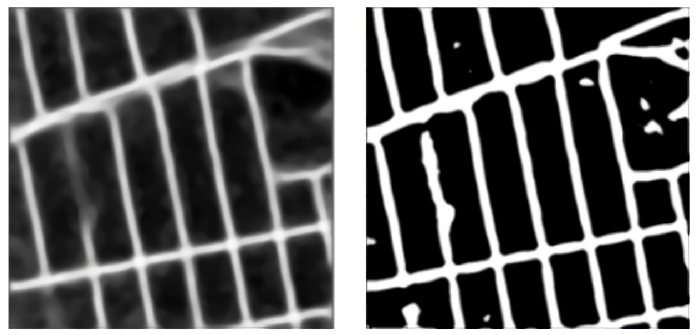
Figure 8. Gaussian adaptive thresholding. The left side is the original image and the right side is the thresholded